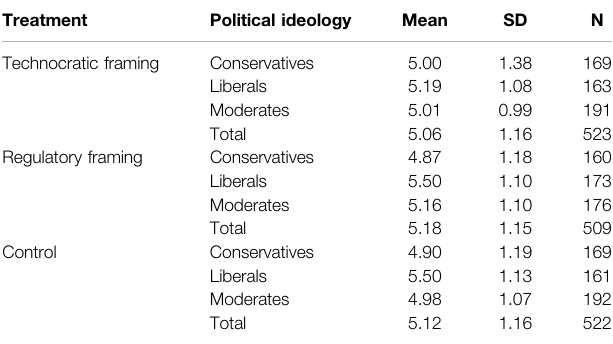
FIGURE 5 | Means with 95% con fi dence intervals for study variables regarding attitudes toward science and the COVID-19 pandemic grouped by political ideology.Signi fi cantdifferences( p < 0.01)revealedbyapost-hocTukey ’ sTestaredenotedbylettersaboveeachbar.Groupssharingthesameletterarenotsigni fi cantly differentfromeachother.Measuredona7 ptLikertscalewhere1 (cid:1) ‘ stronglydisagree ’ and7 (cid:1) ‘ stronglyagree ’ .Thedashedlinethroughpoint4onthey-axisrepresents the ‘ neutral ’ choice within the 7 pt Likert Scale.